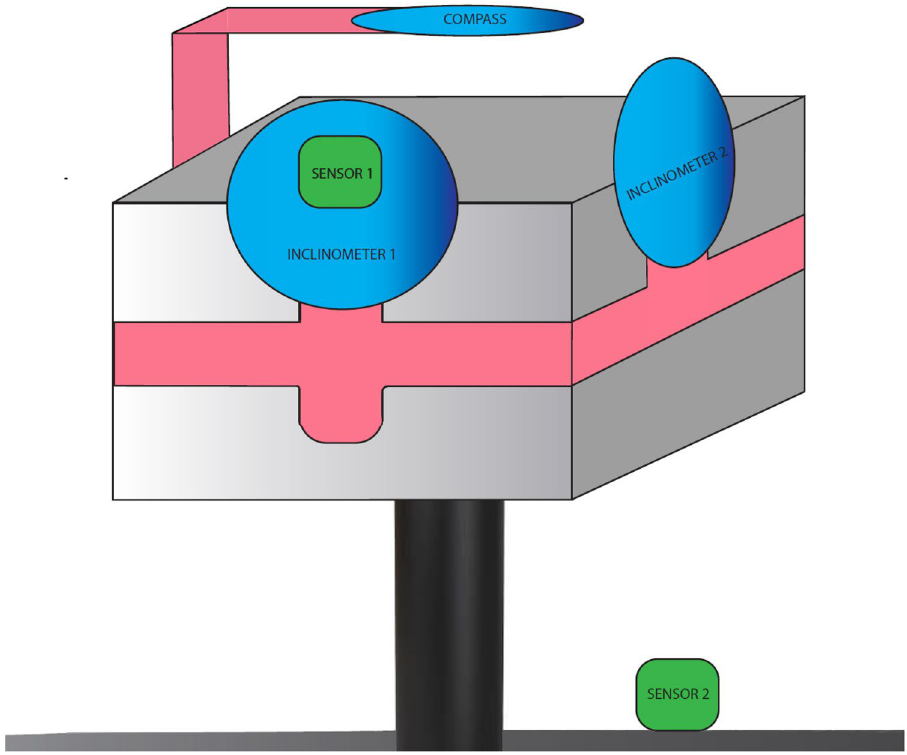
Figure 2. Representative image for the in vitro assessment of the inertial measurement unit. A box-shaped model (grey) was used with the cervical range of motion device (pink and blue) placed on top. The first sensor (green) was placed on the inclinometer 1, and the second on the table. It was possible to move and block this model on the 3 axes